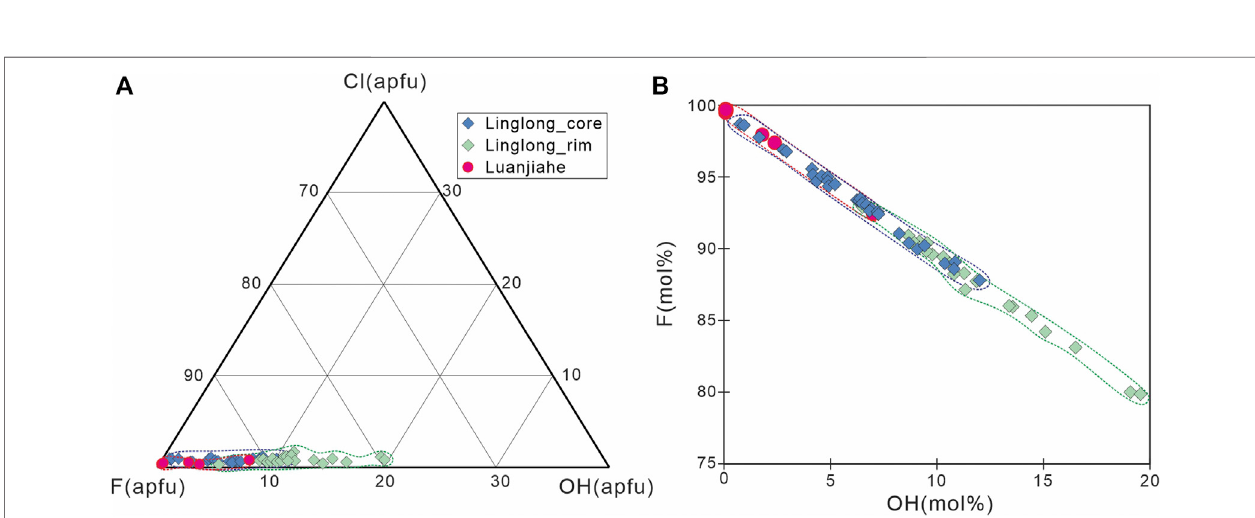
FIGURE 6 | (A) Chondrite-normalized REE pattern of zircon (A) and apatite (B) from Linglong and Luanjiahe granites. Chondrite normalizing values are from Sun and McDonough (1989).